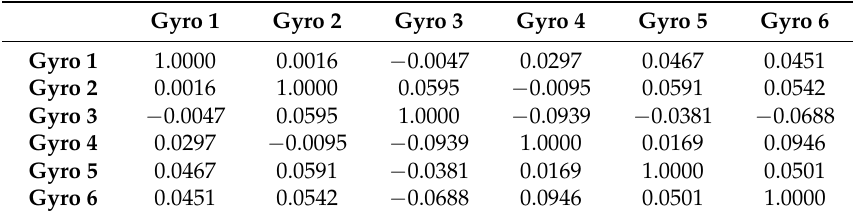
Table 1. Correlation factor between the component gyroscopes.